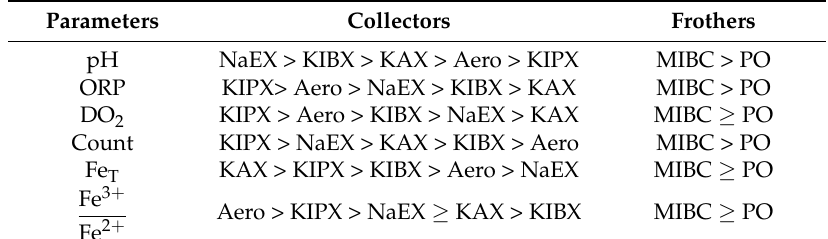
Table 1. The order of negative effects of flotation reagents on biooxidation of both Acidithiobacillus ferrooxidans and Leptospirillum ferrooxidans activities.